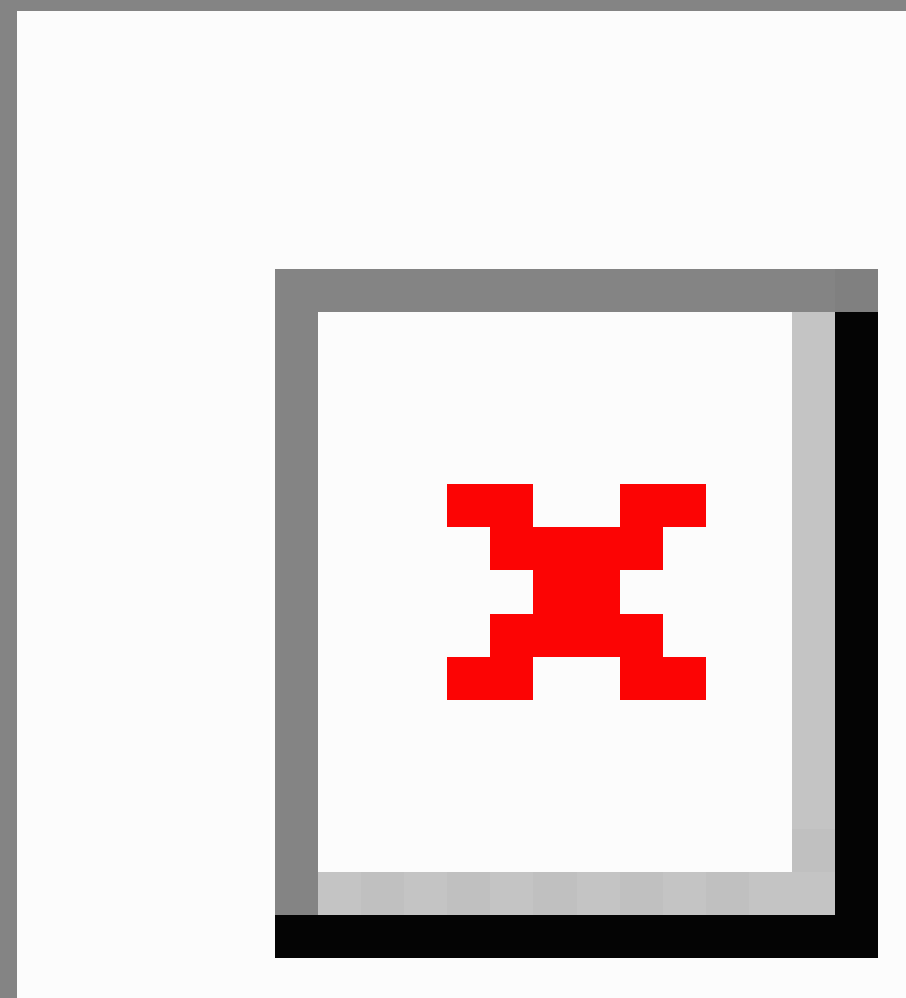
Figure 1. Screenshot from OBO, Session 3: "How do I